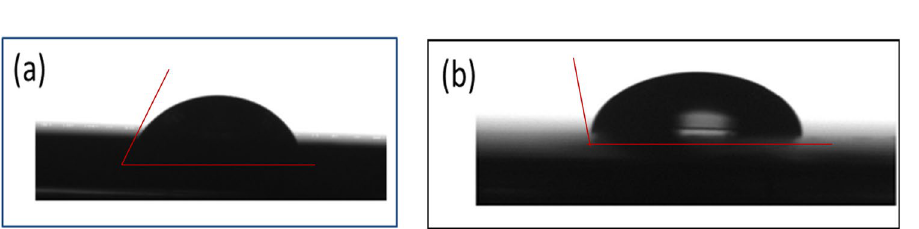
Figure 13. Water droplet contact angle on mild steel surfaces exposed 24 h to 3.5 wt.% NaCl solution: ( a ) bare surface, and ( b ) coated surface by Ch/GA